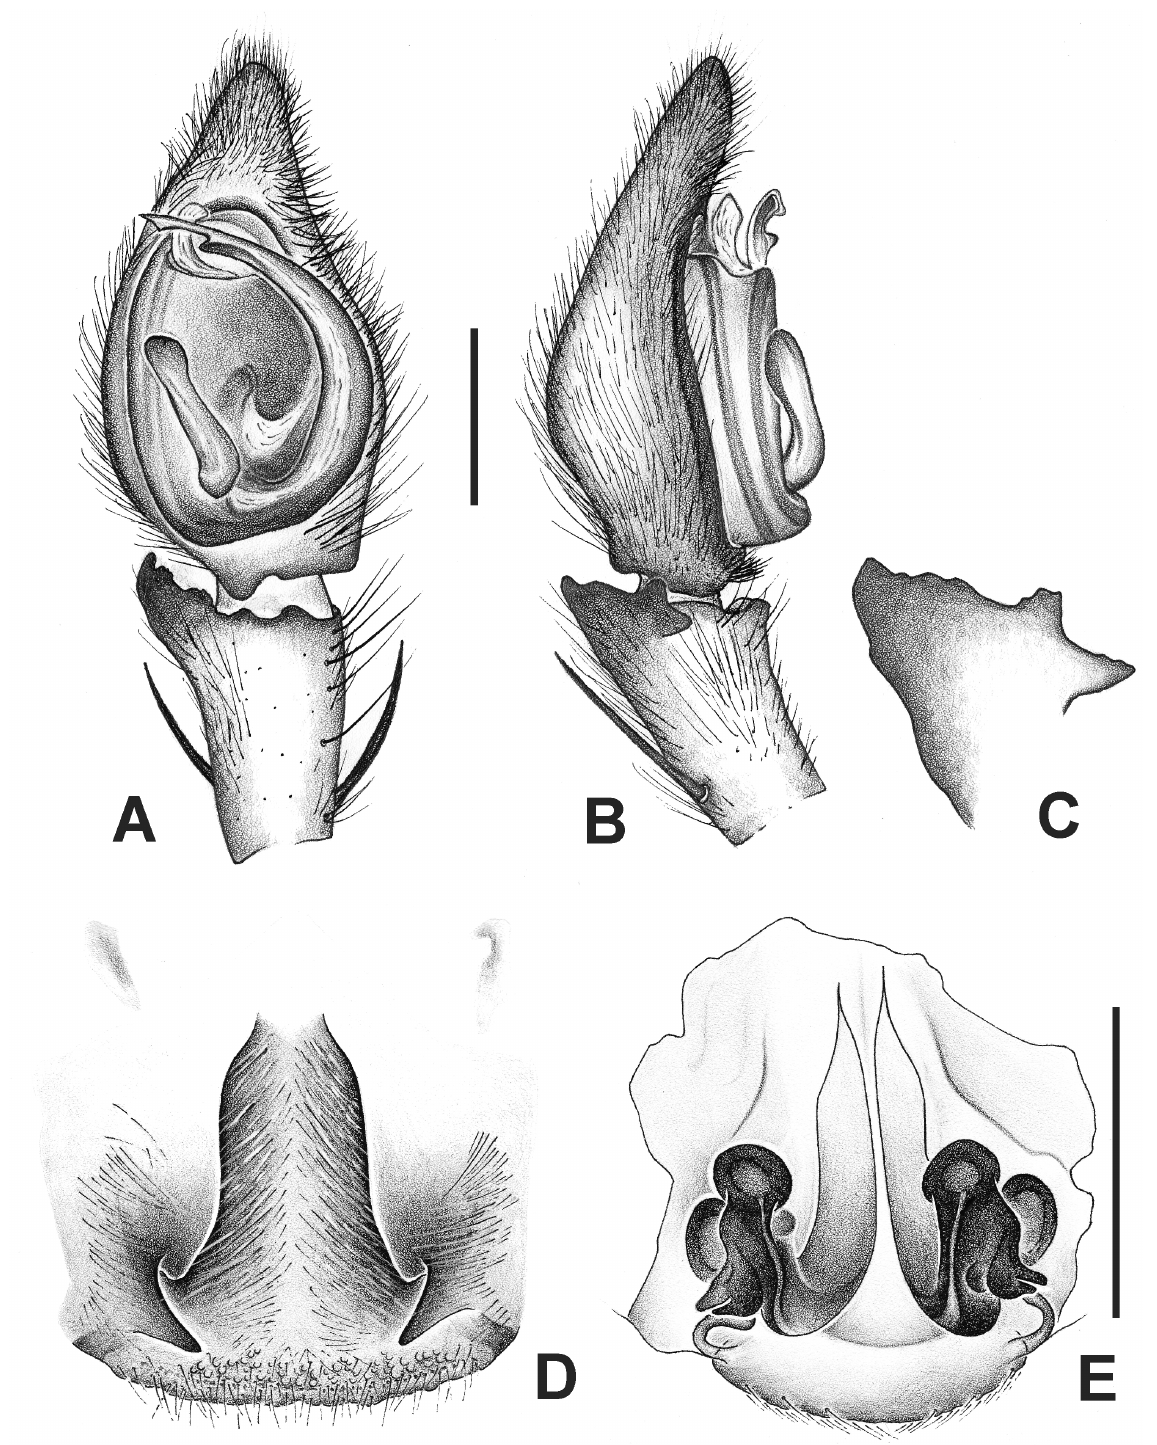
Fig. 5. Afroneutria immortalis (Arts, 1912) comb. nov. — A–C . Male palp. A . Ventral view. B . Retrolateral view. C . Retrolateral tibial apophysis, lateral view. — D–E . Female genitalia. D . Epigynum, ventral view. E . Vulva, dorsal view. Scale bars = 1